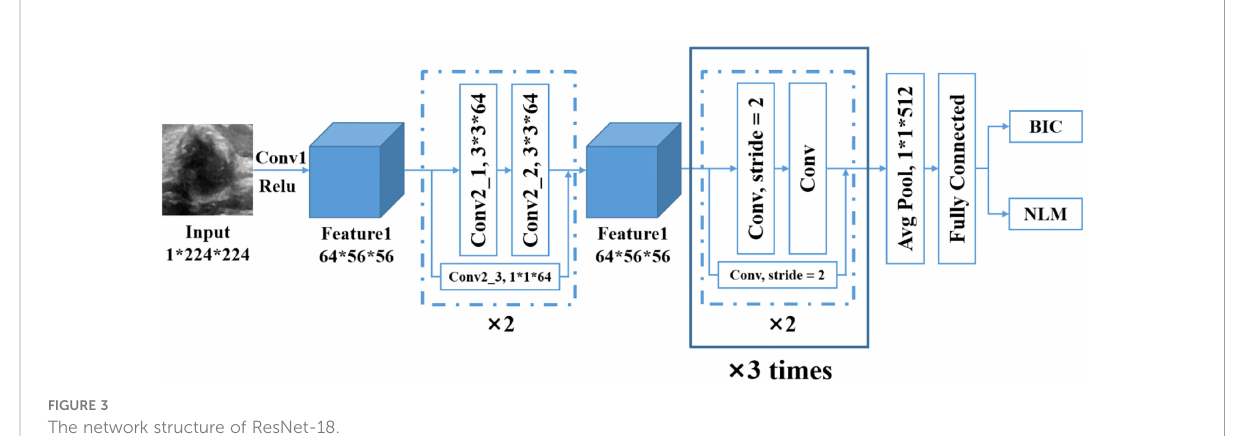
FIGURE 3 The network structure of